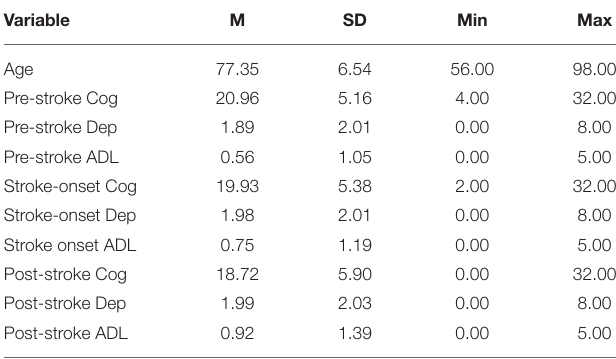
TABLE 1 | Descriptive statistics for continuous